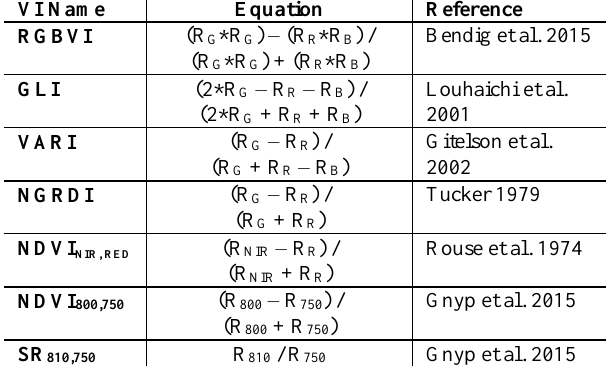
Table 1. Applied Vegetation indices. R = reflectance (%),